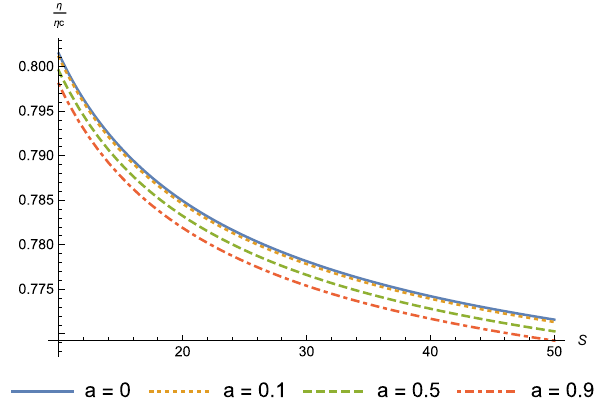
Fig. 12 Rateof η/η c asafunctionoftheentropy, S ,fordifferentvalues of